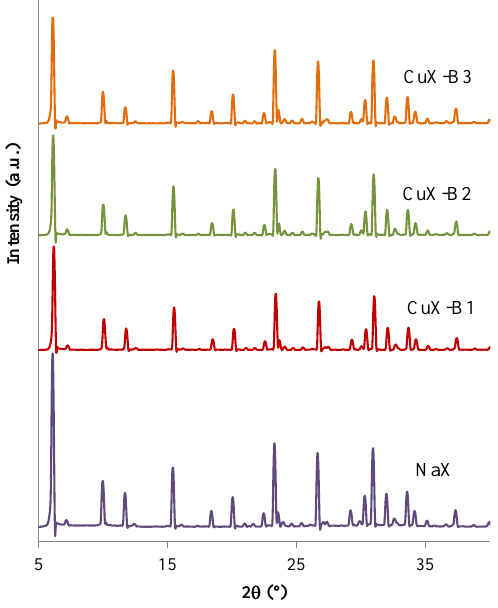
Figure 2. XRD patterns of the NaX and copper-exchanged